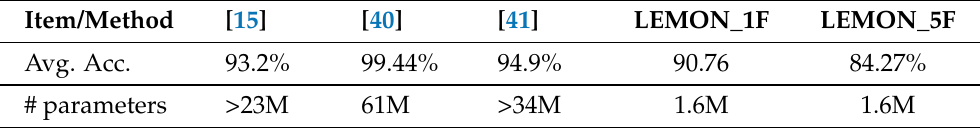
Table 8. Comparison of our approach, trained with one-fold and five-fold cross-validation, with respect to the state-of-the-art methods on the CK+ Dataset in terms of average accuracy and number of